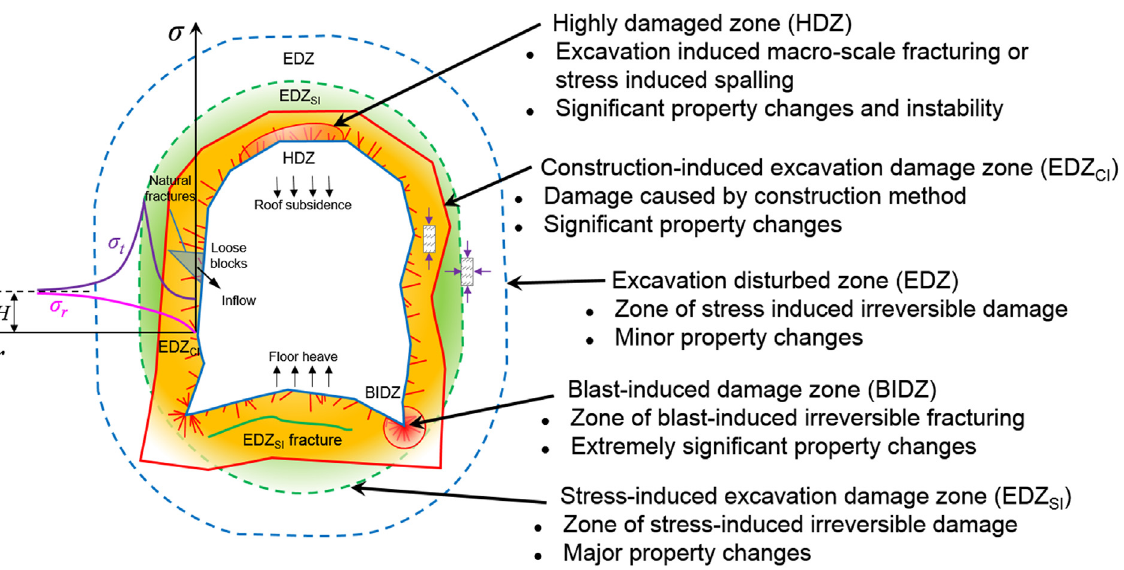
Fig 1. Overview of the different damage zones around an underground excavation, where σ r is the radical stress, σ t is the tangential stress, γ is the average bulk force of the overlying strata, and H is the burial depth of the excavation (adapted from the work by